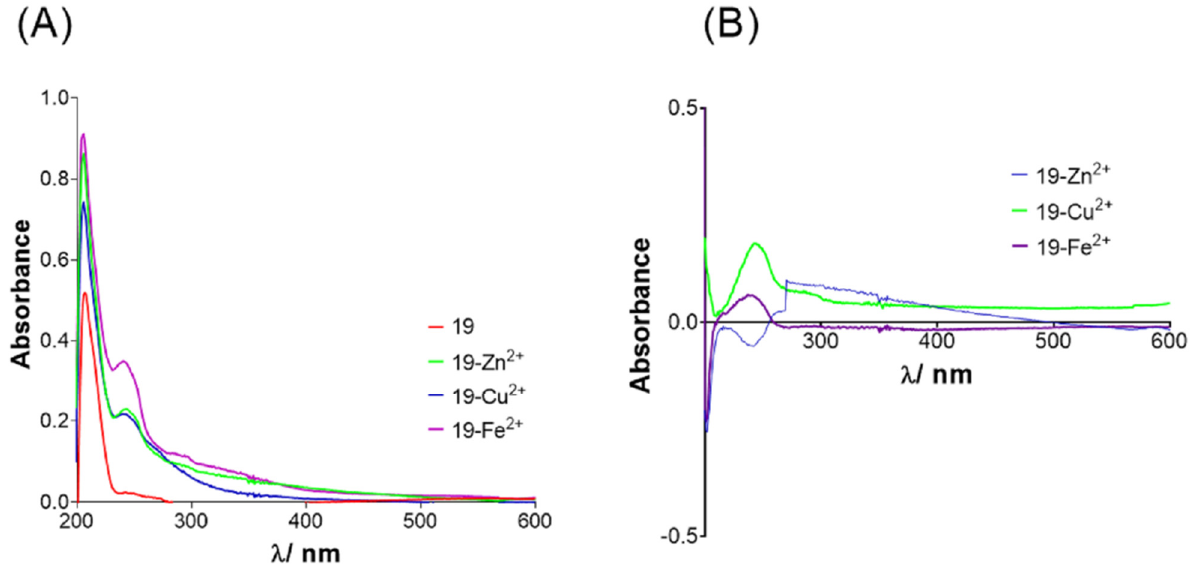
Figure 5. ( A ) The UV–VIS spectra of biscarbamate 13 alone (red) and in the presence of Zn 2+ (green), Cu 2+ (blue) and Fe 2+ (purple) recorded after 30 min of incubation. ( B ) The differential spectra of 13 − Zn 2+ (green), 13 − Cu 2+ (blue) and 13 − Fe 2+ complexes (purple).